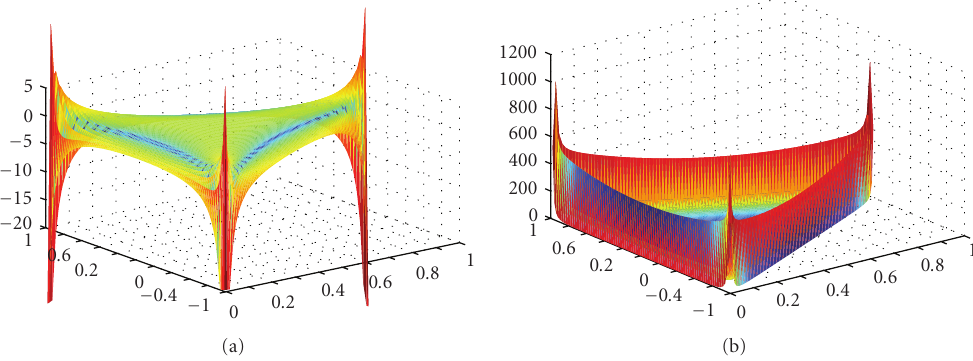
Figure 6: Shape functions for the nearly scale-invariant “warm” and “flat” NG models: S ( k 1 , k 2 , k 3 ) = S ( (cid:11) α , (cid:11) β ) on transverse slices with 2 (cid:11) k = k 1 + k 2 + k 3 = const . These distinct and independent shapes prove to be largely uncorrelated with each other and the local and equilateral models illustrated in figure; from the study by Fergusson and Shellard in [9]. See main text for the definition of the coordinate reparametrization in terms of (cid:11) α ( y -axis) and (cid:11) β ( x